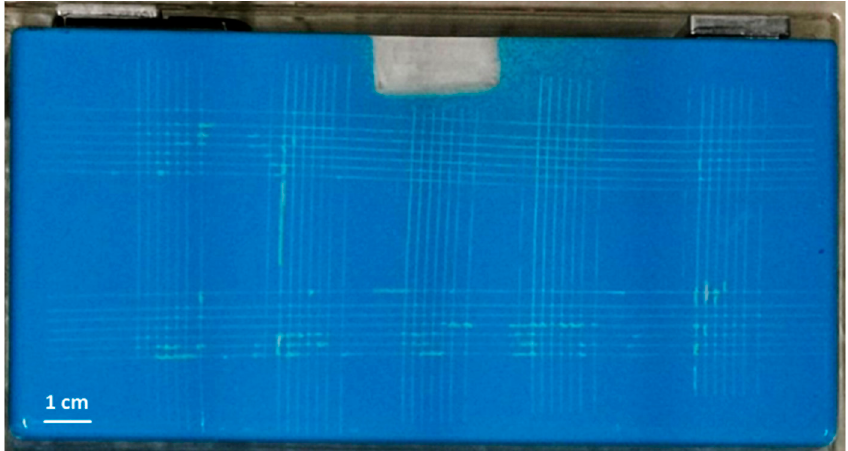
Figure 2. Photo of a battery cell with cross-cut